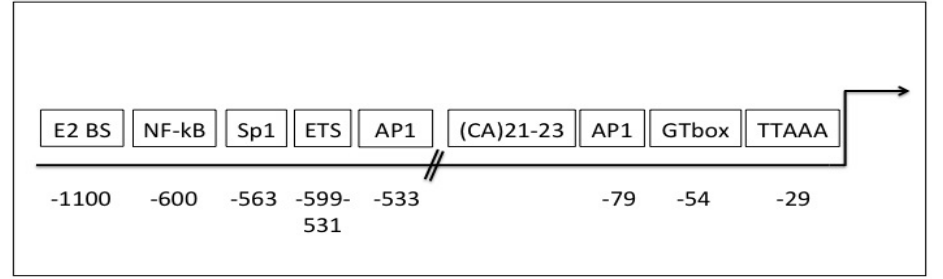
Figure 1. Localisation of functional transcriptional elements within the human MMP-9 promoter, displaying the positions, relative to the MMP-9 translational start site, for E2 protein (E2 BS), nuclear factor-kappa binding (NF-κB), specific protein-1 (Sp1), E26 transformation specific (ETS), CA repeat, activator protein-1 (AP1), GTbox and Tata box binding